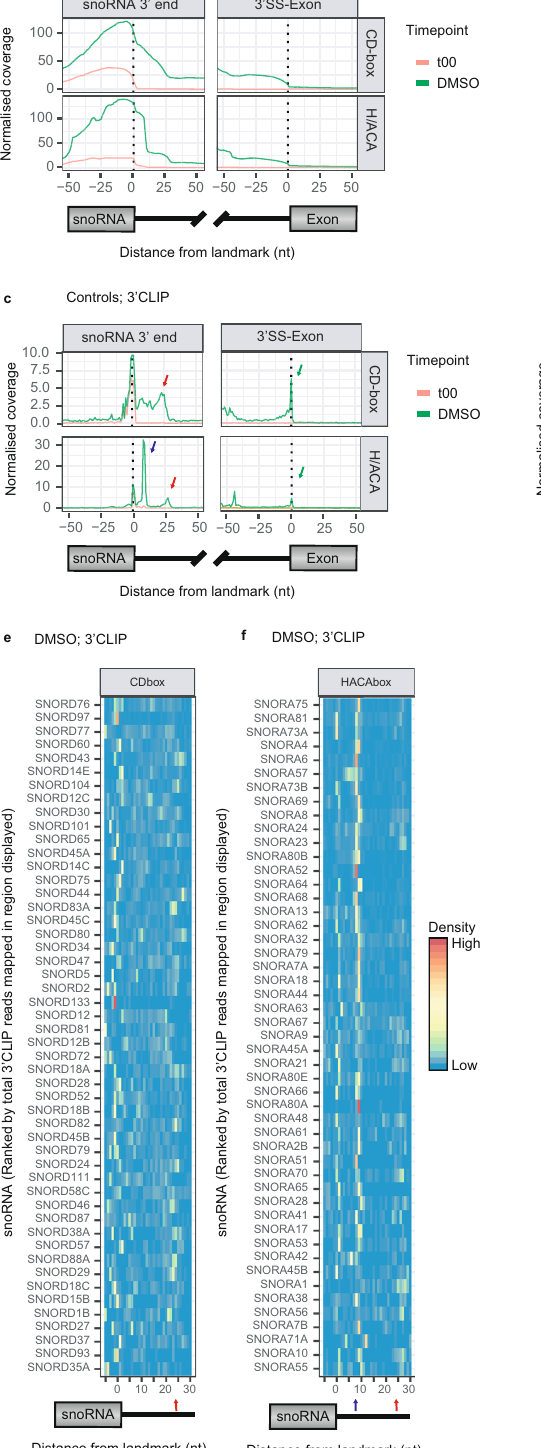
snoRNAs at 9nt. a – d 487 snoRNAs were used in this analysis. e , f Heatmaps depicting3 ′ CLIPsignalsdownstreamofCD-box( e )orH/ACA-box( f )snoRNAs.The 50 snoRNAs with the most cumulative total 3 ′ CLIP signal present in the displayed 35nt window are shown. Coloured arrows as in c , d . g Schematic representation of 3 ′ extended snoRNAs bound by RBM7. Arrows denote 3 ′ extended snoRNAs as also shown in c – f . Source data are provided as Source Data fi